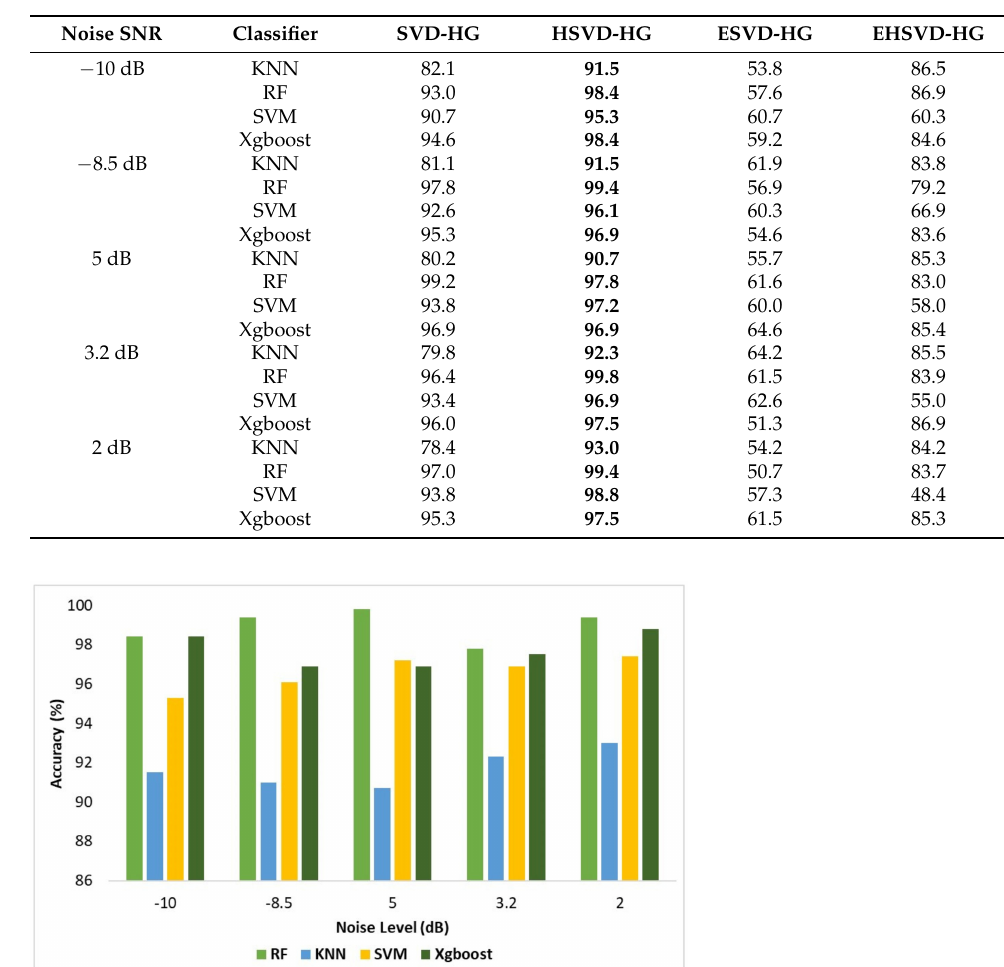
Table 8. Case Study-III: Classifiers Performance on Noisy PD Data.